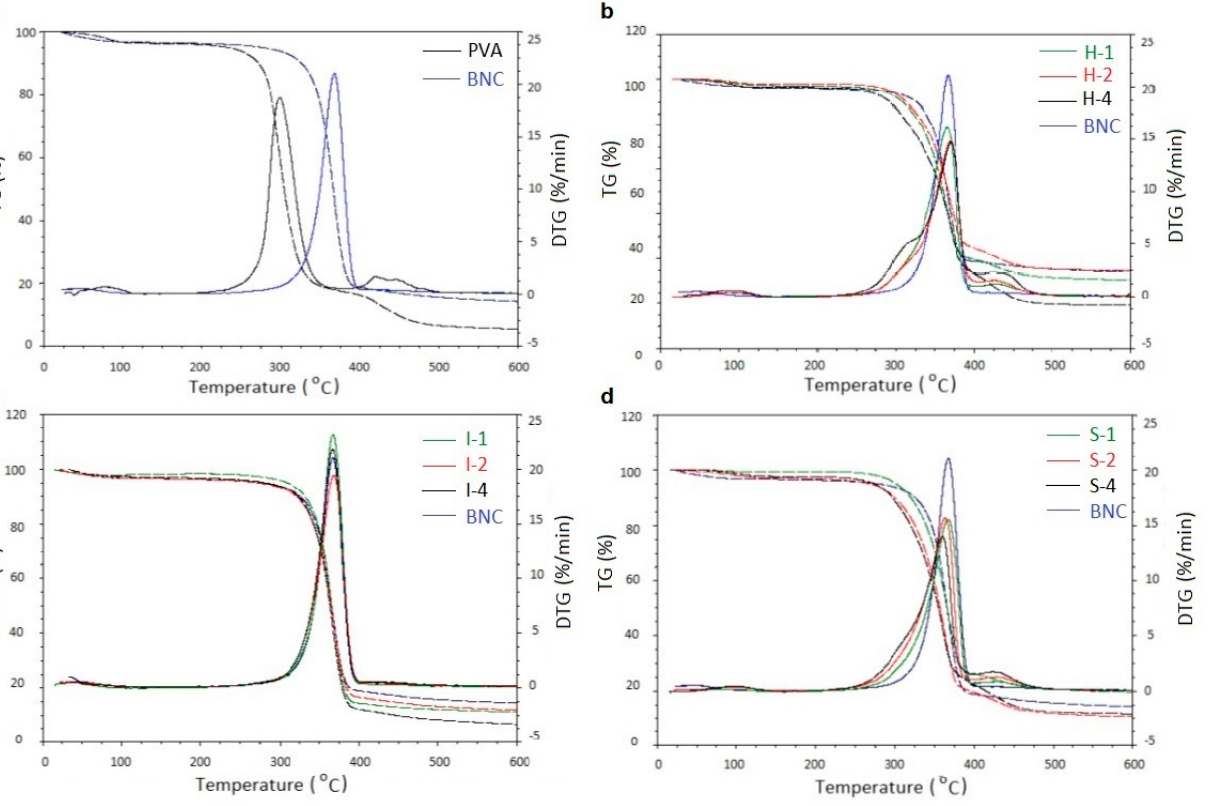
Figure 6. Comparison of TG (dashed lines) and DTG (solid lines) of unmixed BNC and PVA ( a ) materials obtained in situ ( b ), ex situ/impregnation ( c ), and ex situ/sterilization ( d ).